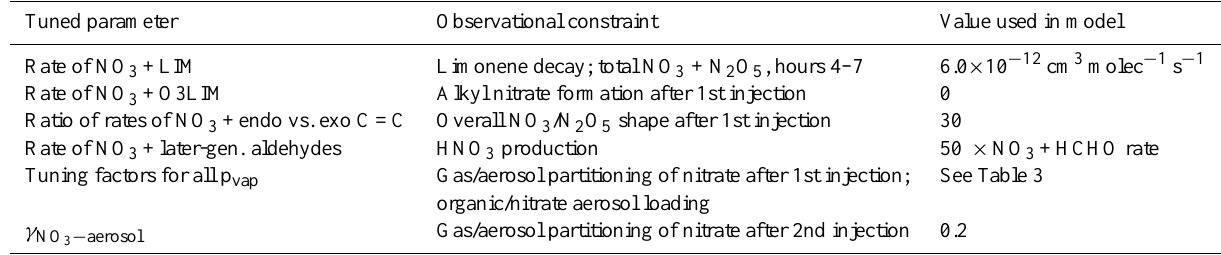
Table 1. Parameters that were tuned in this model to best fit the observational data, along with the observational constraints used to determine best fit.